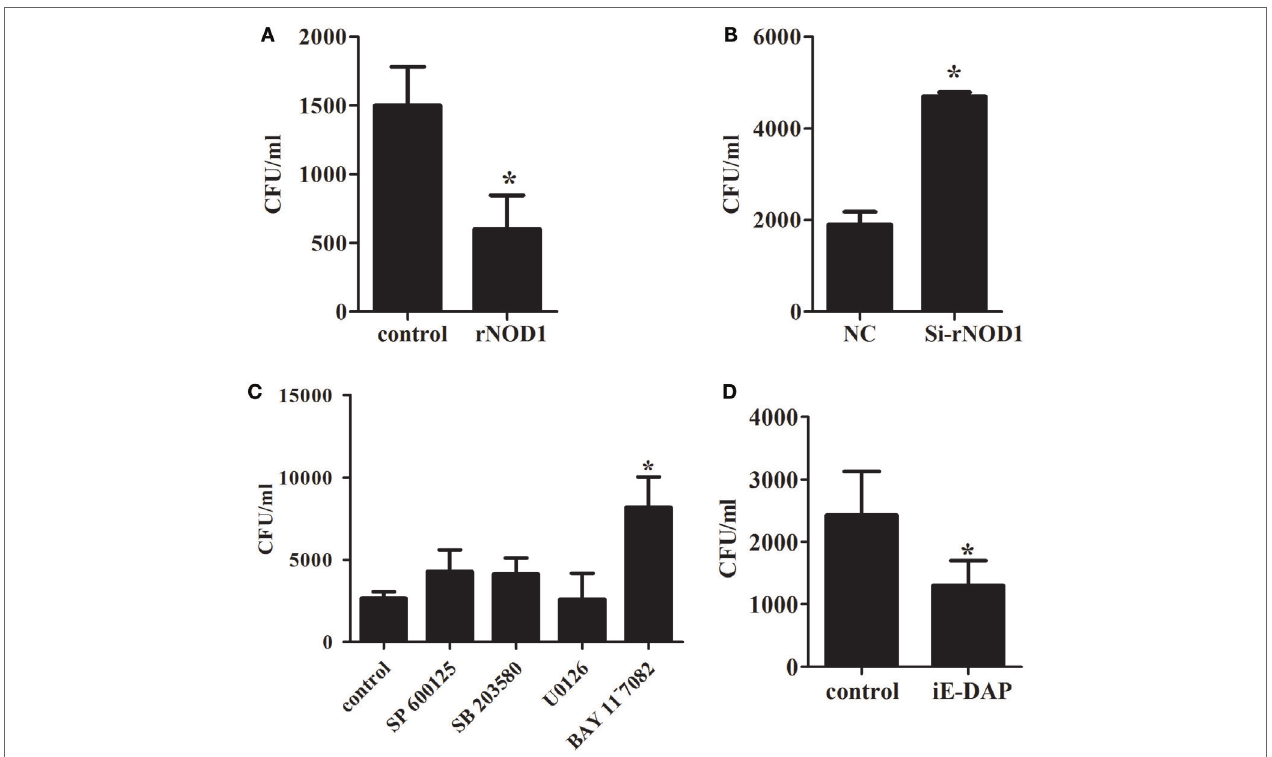
FigUre 5 | Effect of antimicrobial activity with the overexpression or knockdown of rabbit nucleotide-binding oligomerization domain 1 (rNOD1). (a) pC-rNOD1 and (B) si-rNOD1 were transfected into RK-13 cells for 24 h. pCDNA3.1-empty and negative control (NC) siRNA were used as controls, respectively. (c) After 24 h of transfection, cells were treated with 10 µM of SP600125, SB203580, U0126, or BAY11 − 7082 for 12 h. (D) 1 µg/mL of iE-DAP were transfected into cells for 12 h. Cells were infected with 1 × 10 7 Escherichia coli . M ± SD from three independent experiments are presented. Significant differences are indicated by